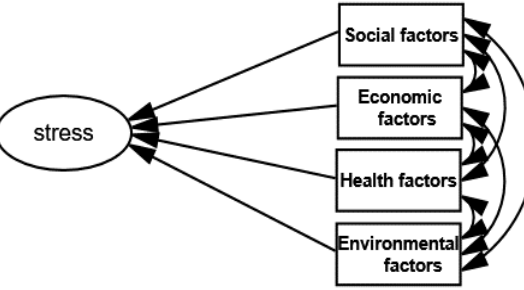
Figure 8. Main hypothetical model of STRESS.